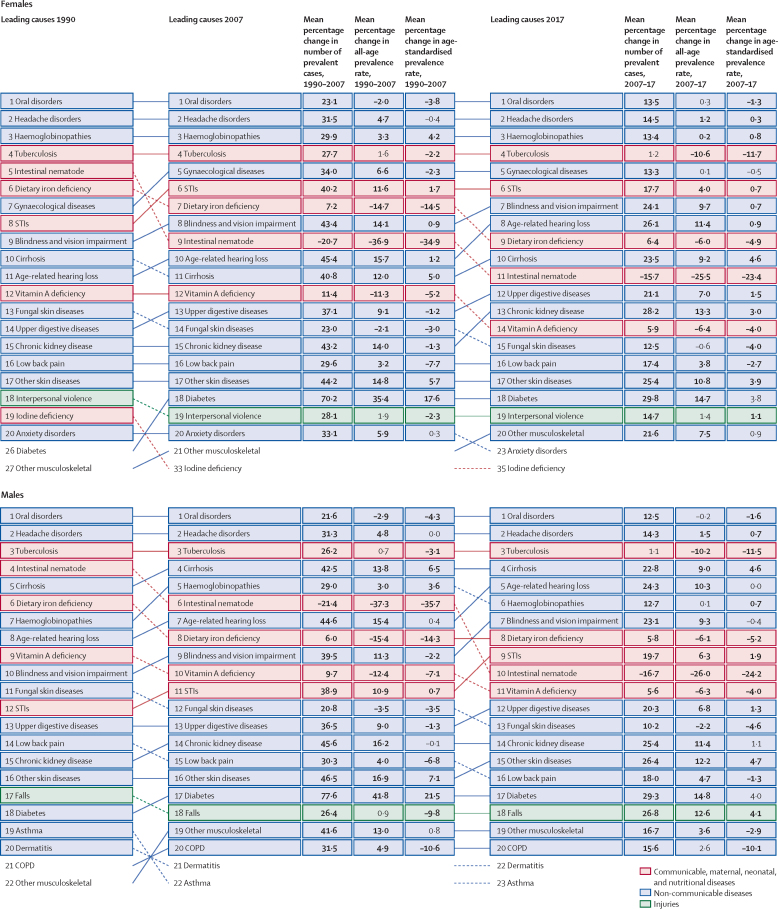
Leading 20 Level 3 causes of global prevalence for 1990, 2007, and 2017, with percentage change in number of cases and all-age and age-standardised rates for each sexCauses are connected by lines between time periods; solid lines are increases and dashed lines are decreases. For the time periods 1990–2007 and 2007–17, three measures of change are shown: percentage change in the number of cases, percentage change in the all-age prevalence rate, and percentage change in the age-standardised prevalence rate. Communicable, maternal, neonatal, and nutritional diseases are shown in red; non-communicable causes in blue; and injuries in green. Statistically significant changes are shown in bold. COPD=chronic obstructive pulmonary disease. STIs=sexually transmitted infections.